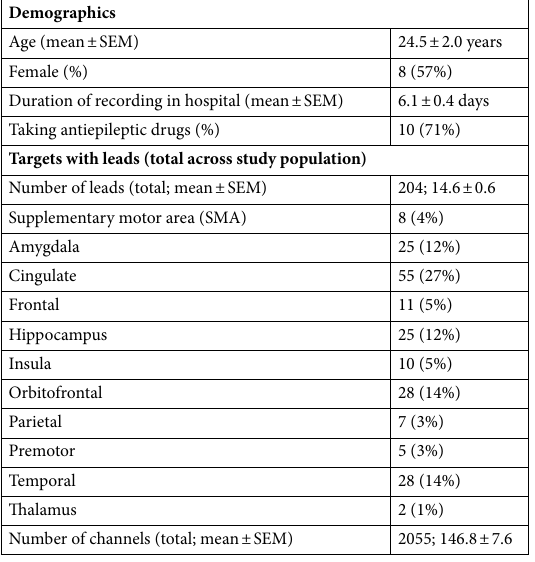
Table 1. Characteristics of the patient population. SEM standard error of the